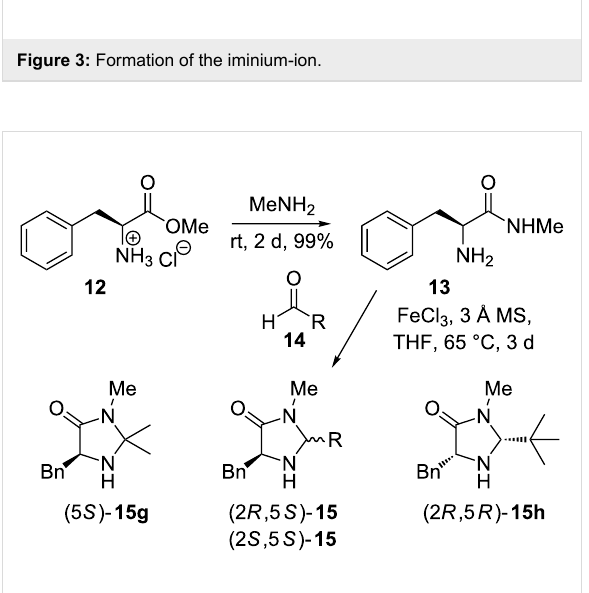
Scheme 3: Synthesis of electron poor imidazolidinone